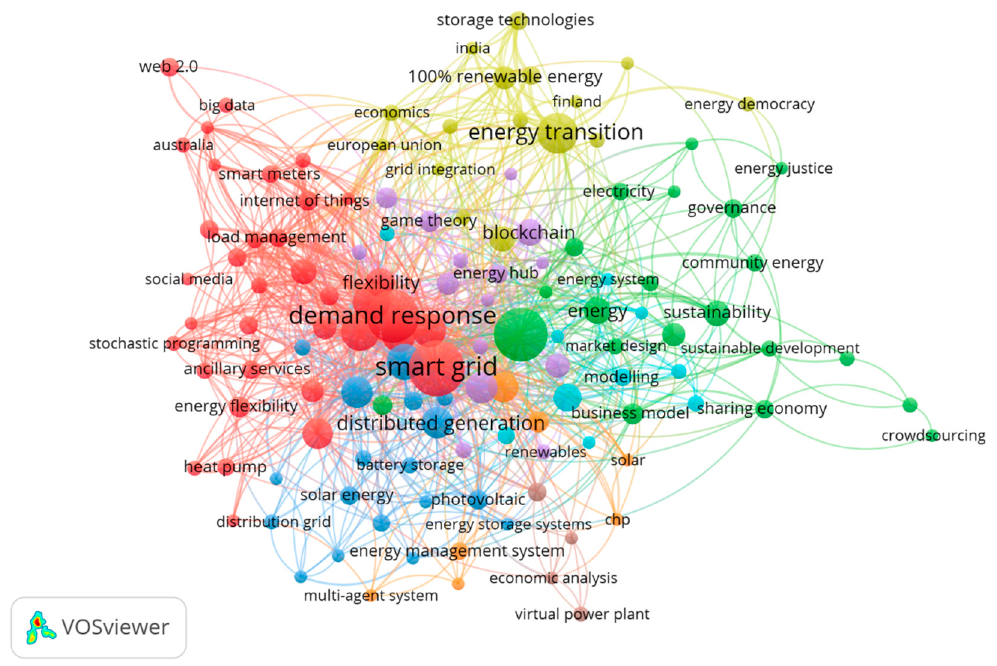
Figure 7. Keyword analysis by VOSviewer.